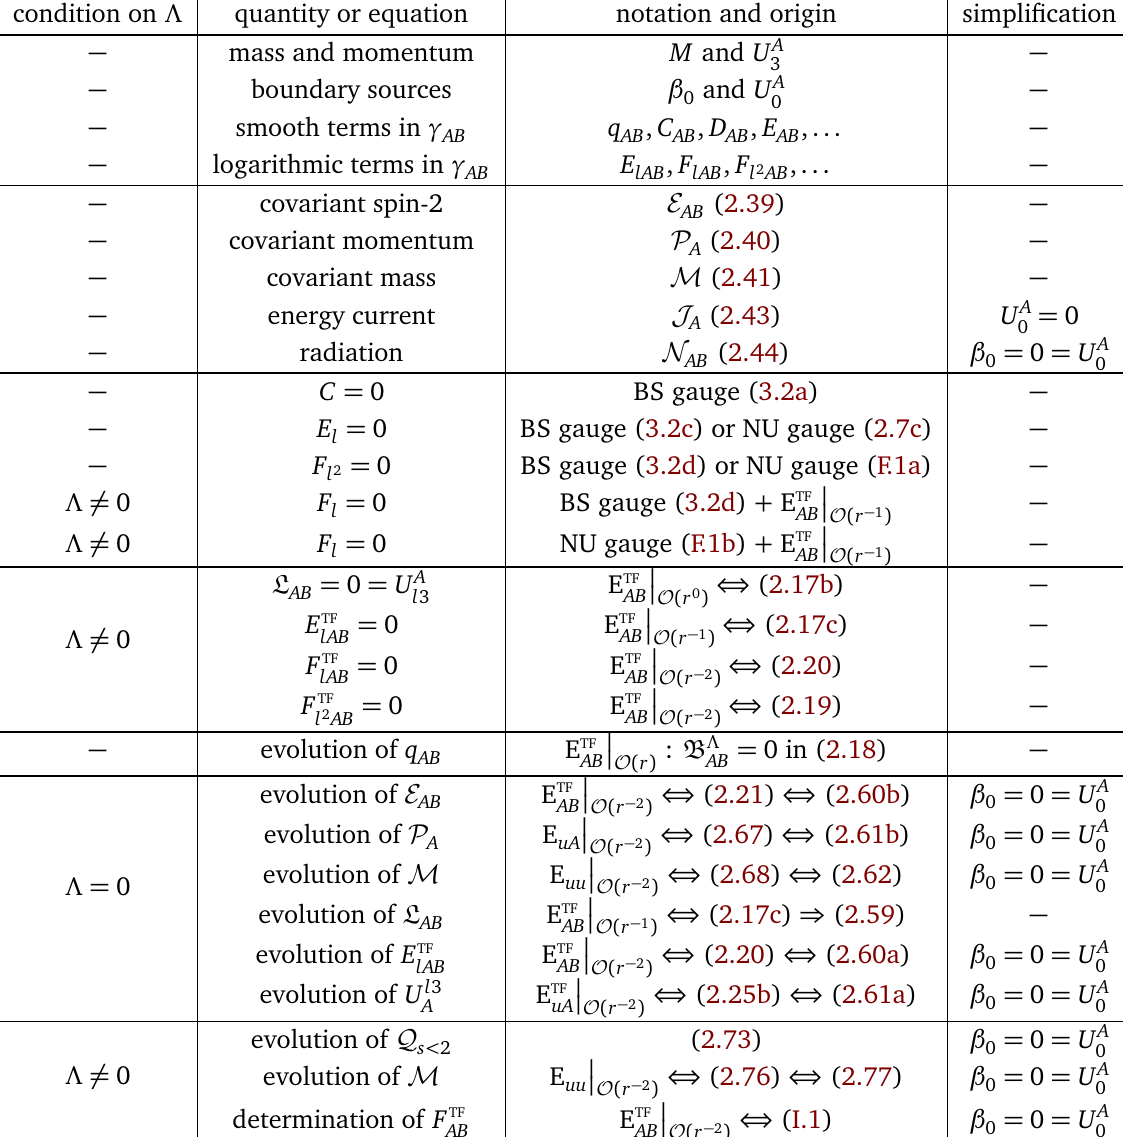
Table 2: Structure of the solution space in partial Bondi